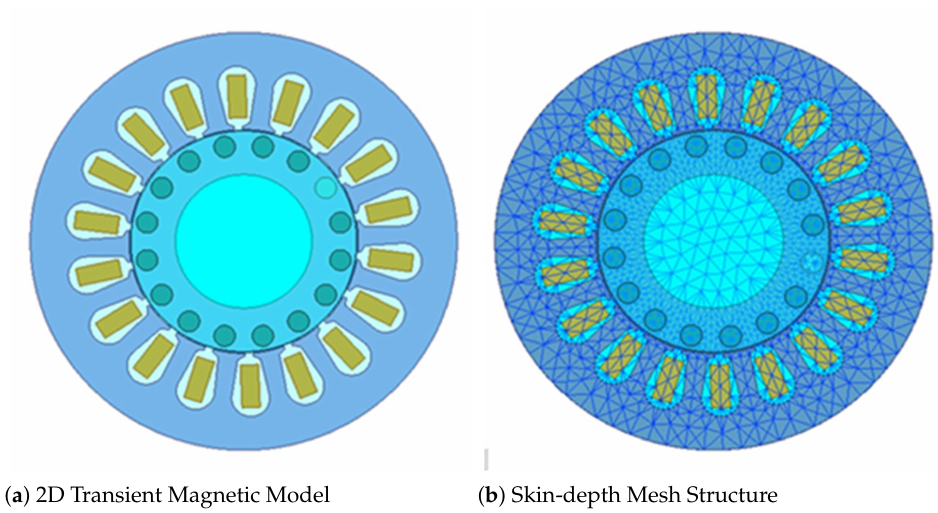
Figure 5. Maxwell 2D Transient Magnetic Model and Skin-depth Mesh